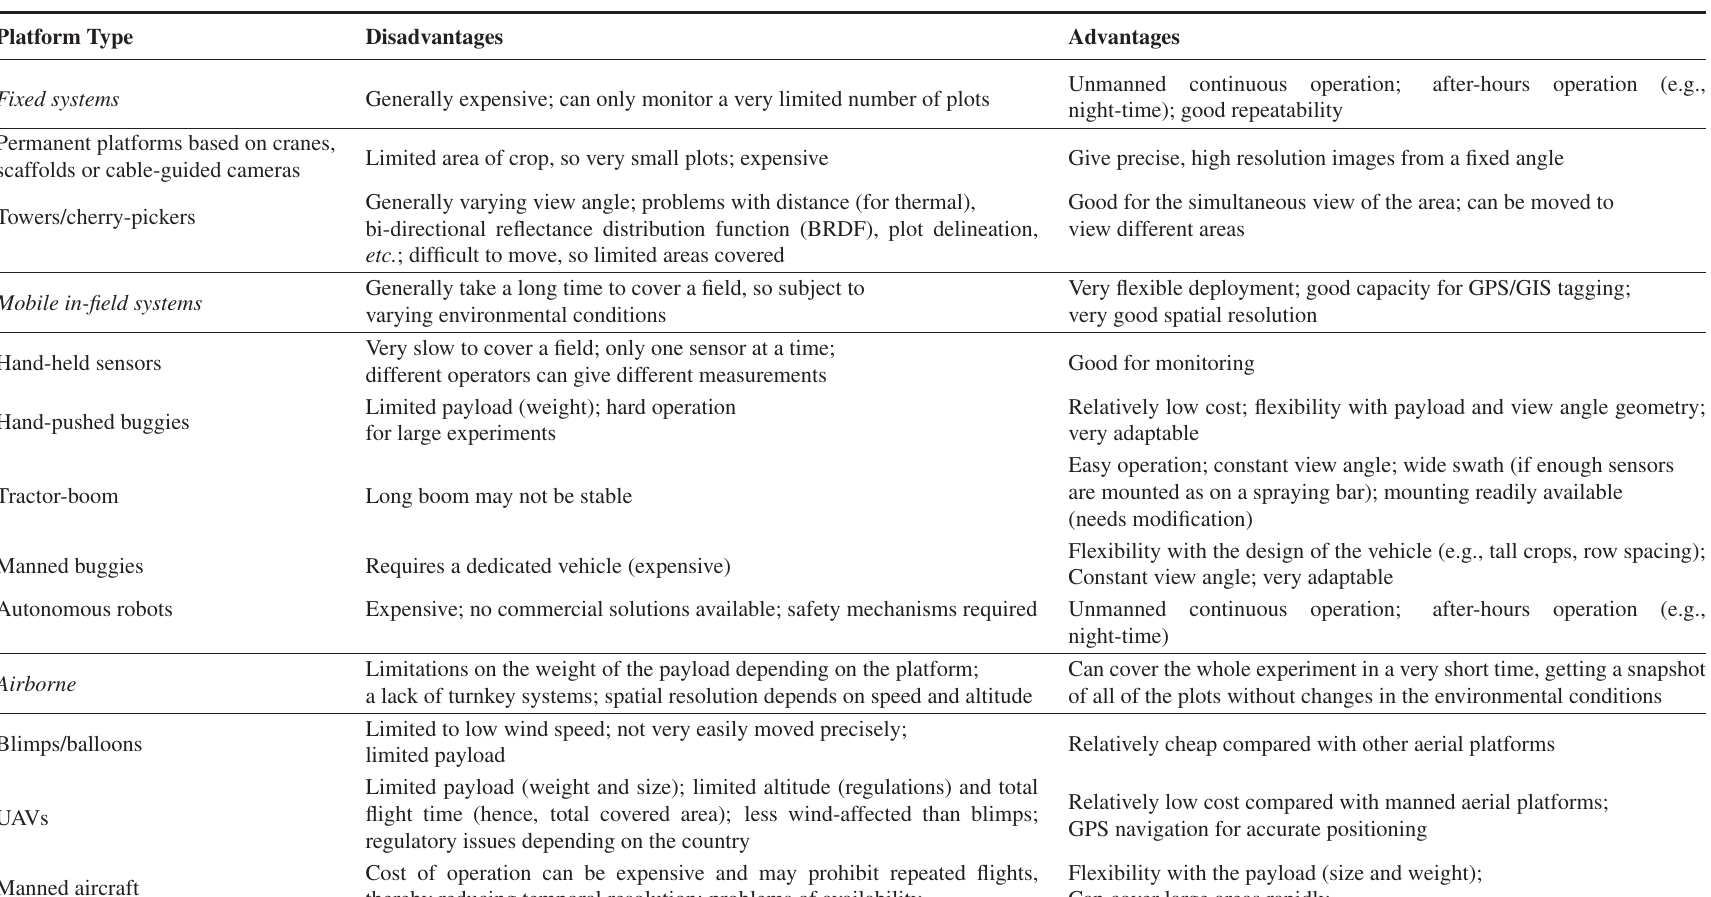
Table 1. Phenotyping platforms and some relative advantages and